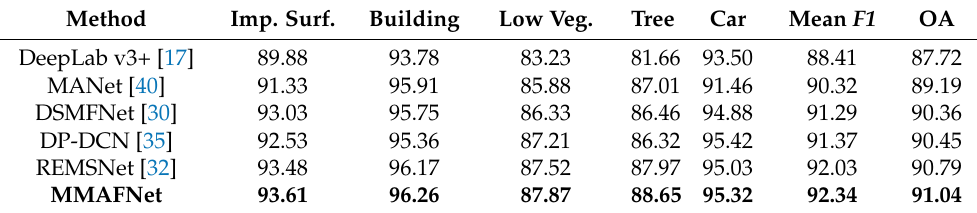
Table 1. Experimental results on the Potsdam dataset (%). Best results are in bold. Method Imp. Surf. Building Low Veg. Tree Car Mean F1 OA DeepLab v3+ [17]